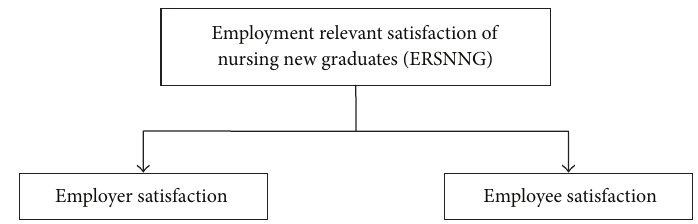
Figure 1: Model for employment relevant satisfaction of nursing new